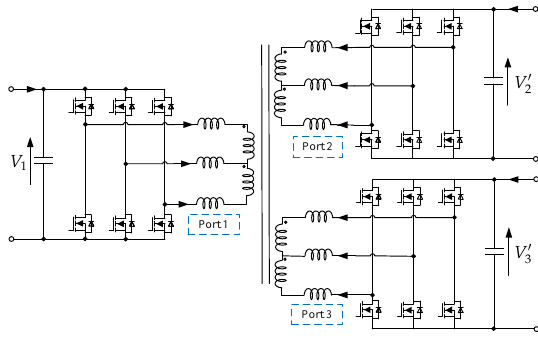
Figure 4. Three-phase TAB